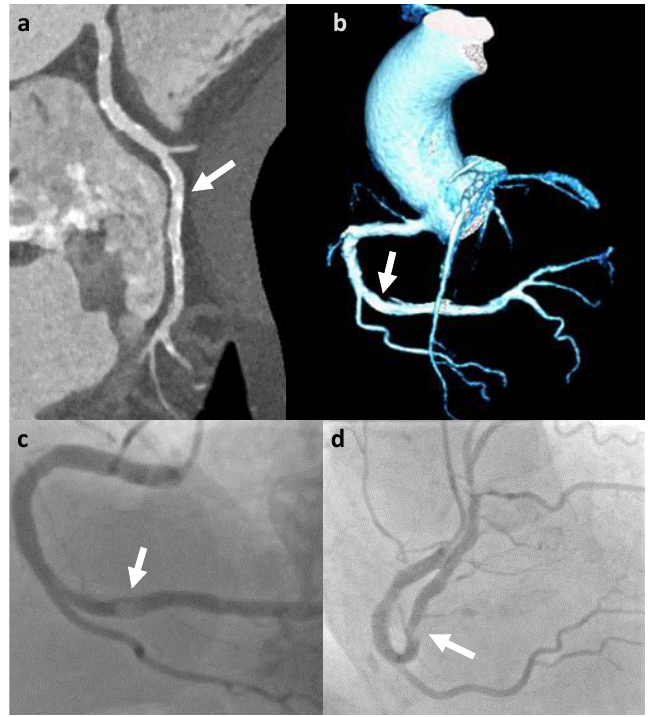
Figure 3. False negative (per vessel) cCTA example (CAC = 2839): Right coronary artery (RCA) with heavy calcifications and excellent contrast opacification (approx. 600 HU) on cCTA with multiplanar reconstruction ( a ) and volume rendered technique ( b ) and invasive coronary angiography depicting a ≥ 50% stenosis in the distal RCA (segment 3) (arrows) ( c , d ), which is masked on cCTA. CAC = coronary artery calcium score.